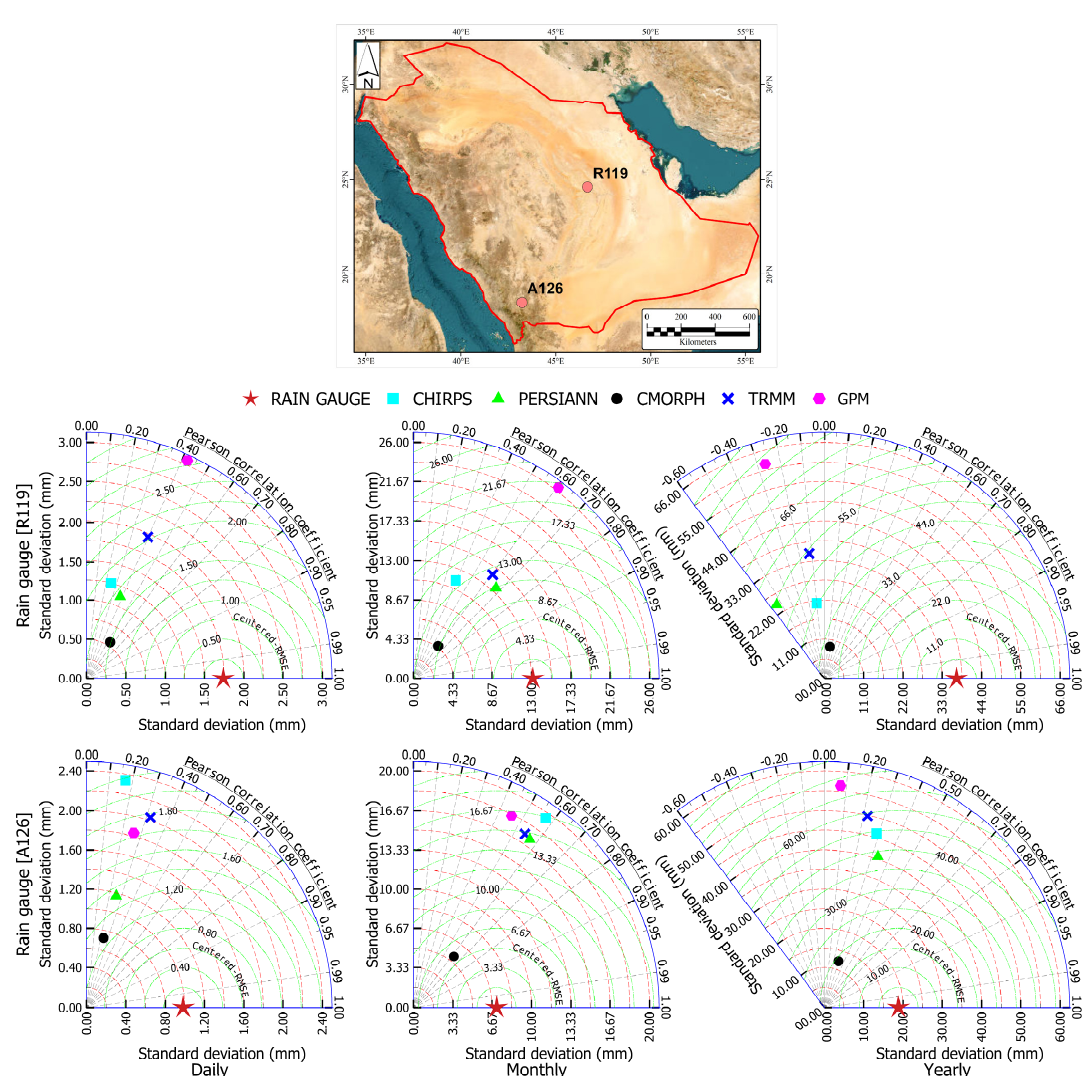
Figure 11. Taylor diagram for rain gauges A126 and R119.